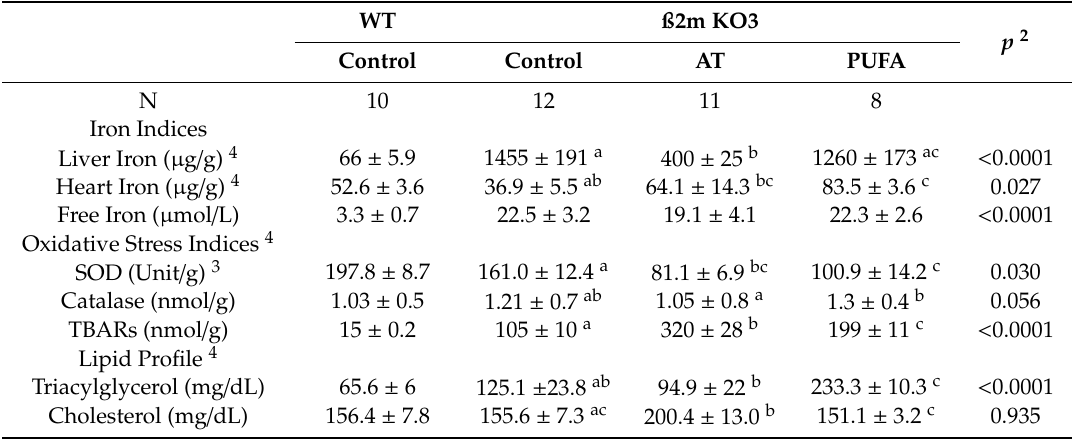
Table 3. E ff ect of dietary fat on liver antioxidant enzyme activity and serum lipid profile in WT and β 2m KO 1.